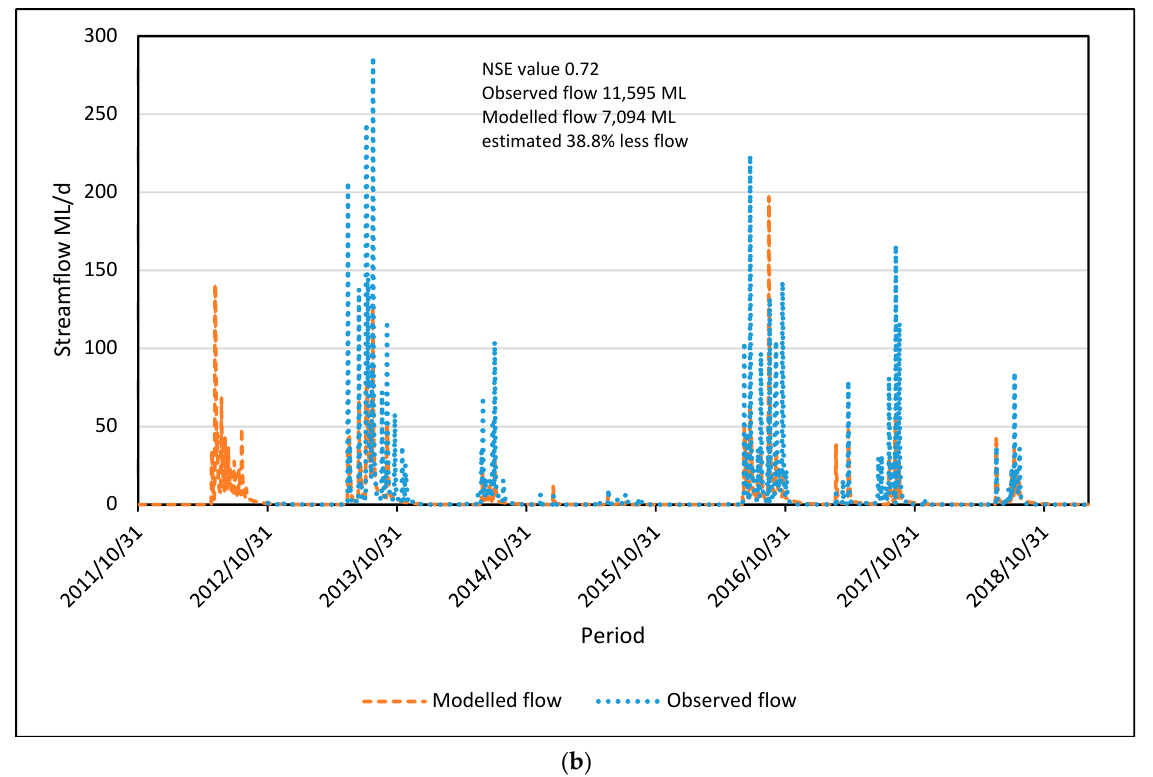
Figure 4. ( a ) AWBM model calibration; ( b ) AWBM model validation.